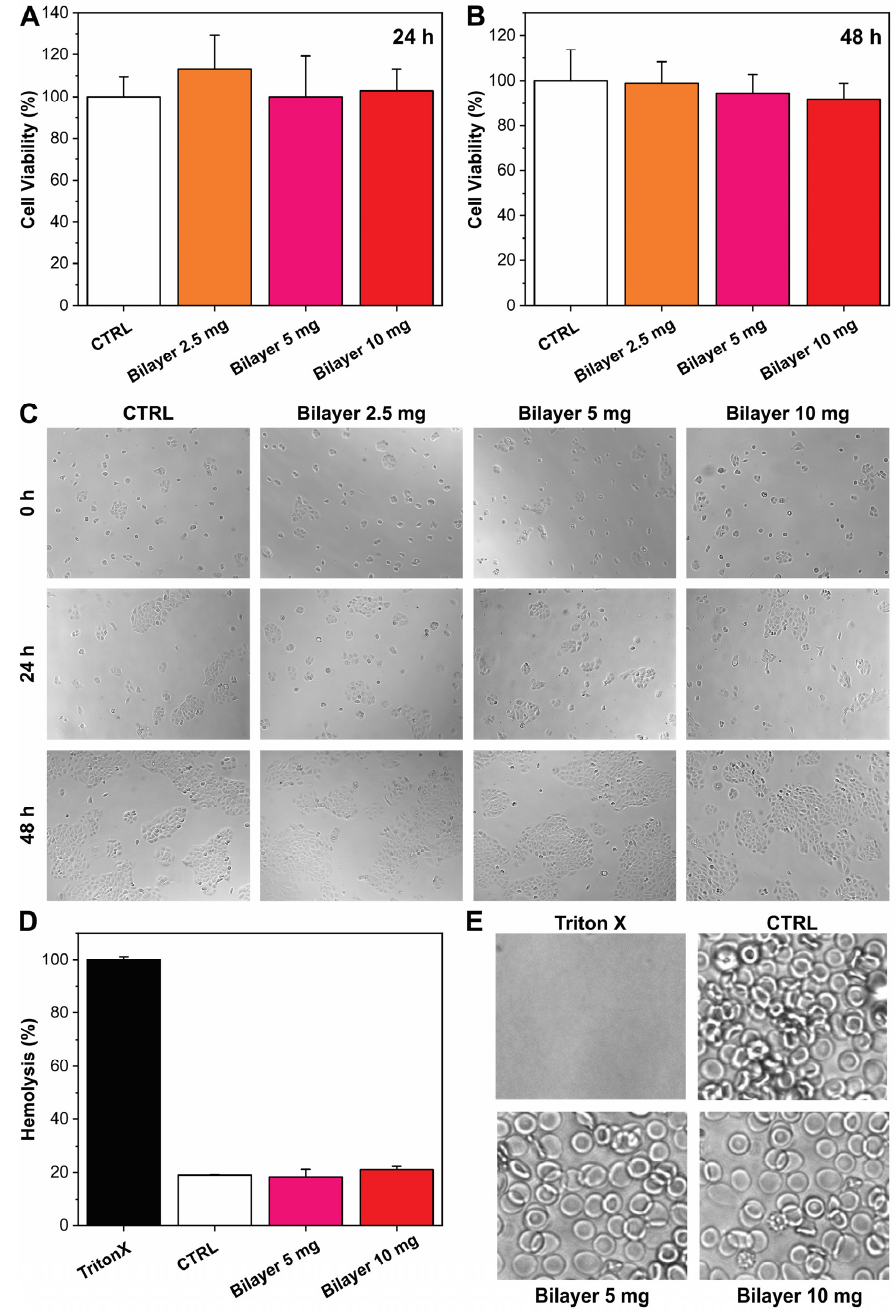
Figure 1. ( A , B ) Viability of HaCaT cells after 24 h and 48 h exposure to bilayer extraction media. Val- ues were normalized to control (set to 100%). Average percentage values ± S.D. of three independent experiments. ( C ) Photos of keratinocytes in the CTRL and bilayer samples at different time points. ( D ) Histogram relative to the absorbance of released Hb after treatment with 4 and 6 mg of bilayer films. The values are expressed as % with respect to the positive control (TritonX). ( E ) Optical images of erythrocytes after the treatment with Triton X, medium, 5 mg, and 10 mg of bilayer,